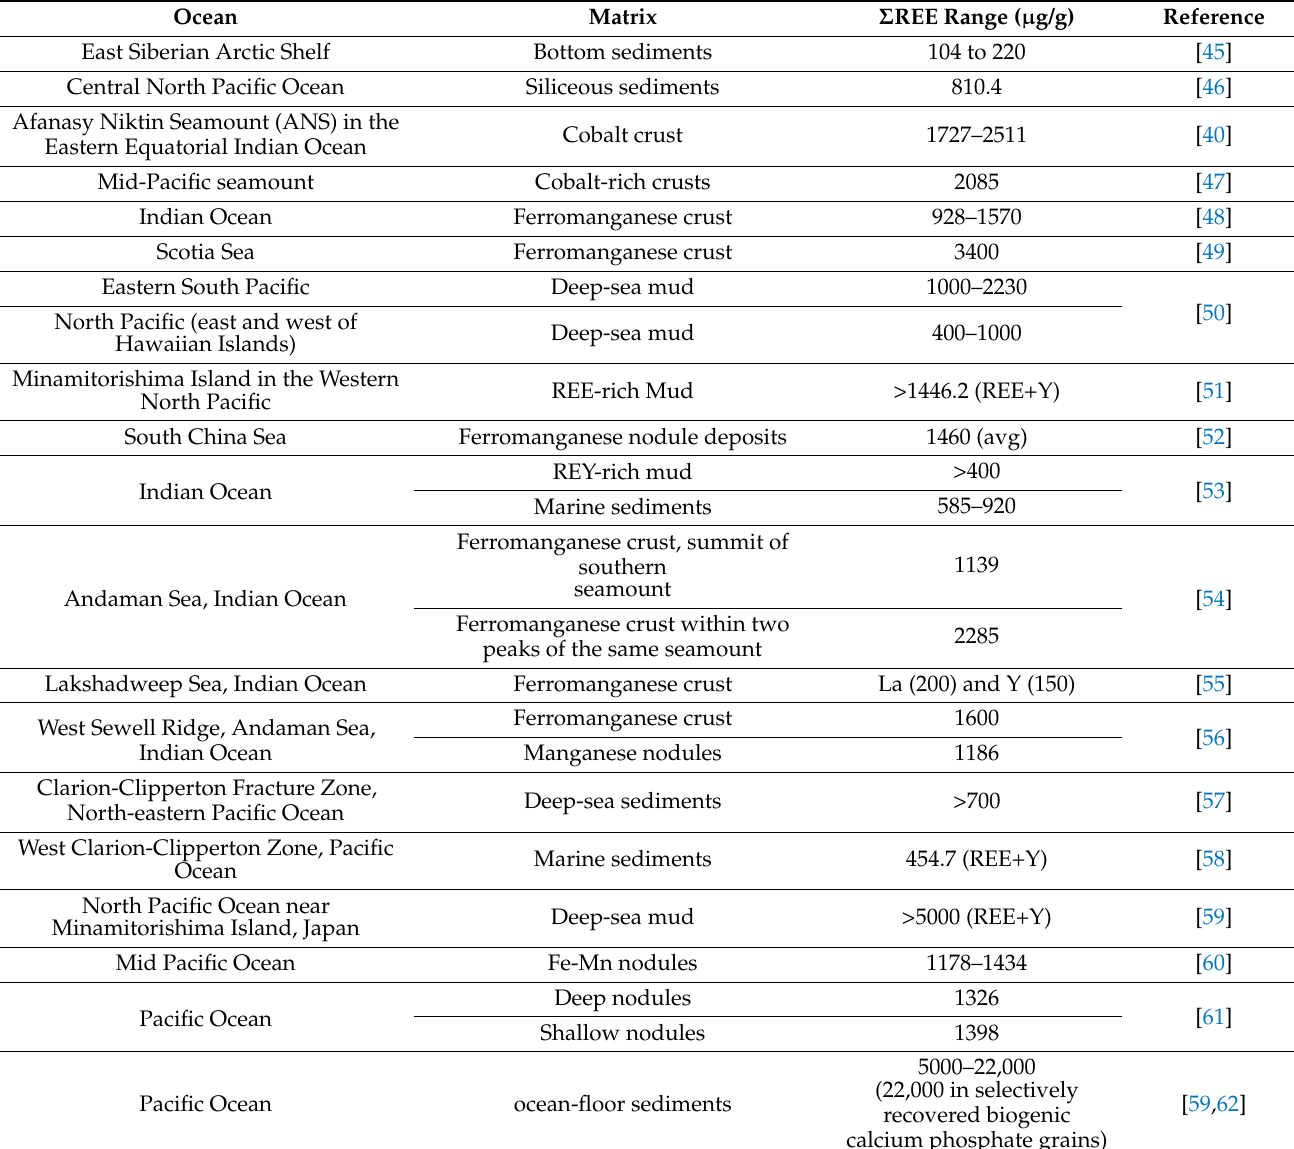
Table 1. Overview of Σ REE range ( µ g/g) in marine sediments from different oceans, modified after [44]. Matrix Σ REE Range ( µ